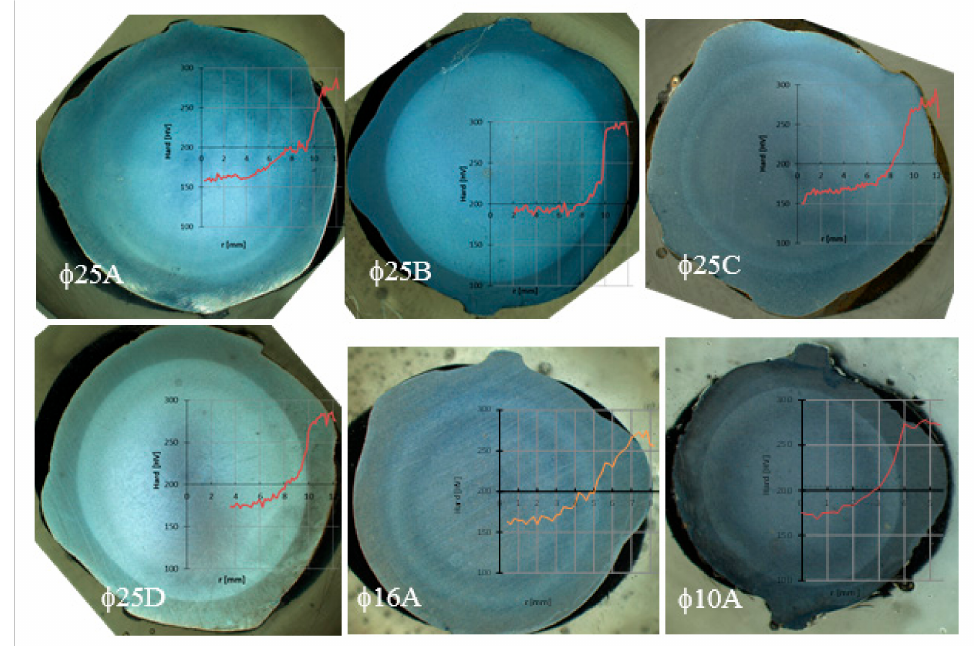
Figure 3. Hardness measurements of di ff erent